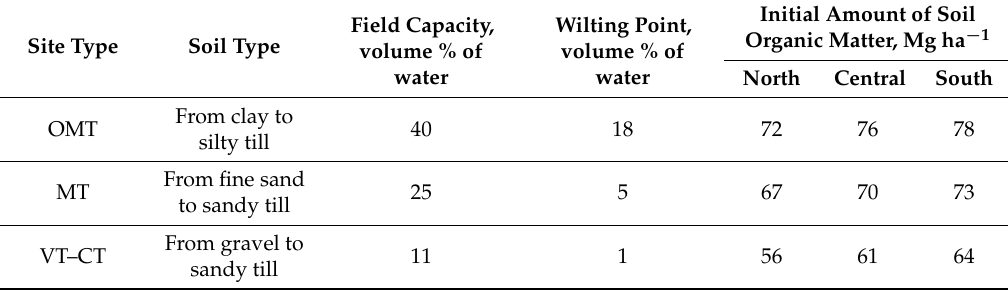
Table 2. Site type with the volume percent (%) of water for field capacity and wilting point (e.g., [36,37]) and the initial amount of soil organic matter used in the simulations for Northern, Central, and Southern boreal regions of Finland [3]. The regions for soil organic matter represent varying thermal